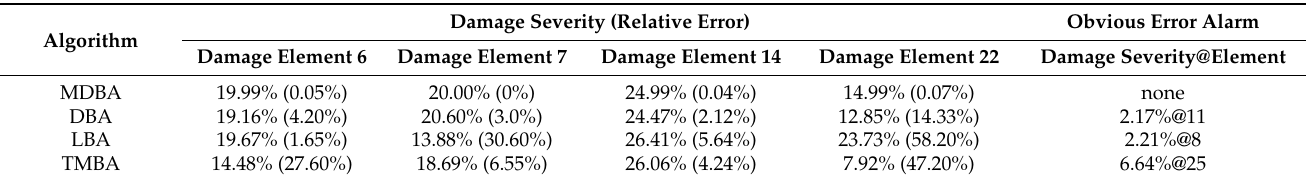
Table 4. The identification results of the damaged case by other variations of BA.